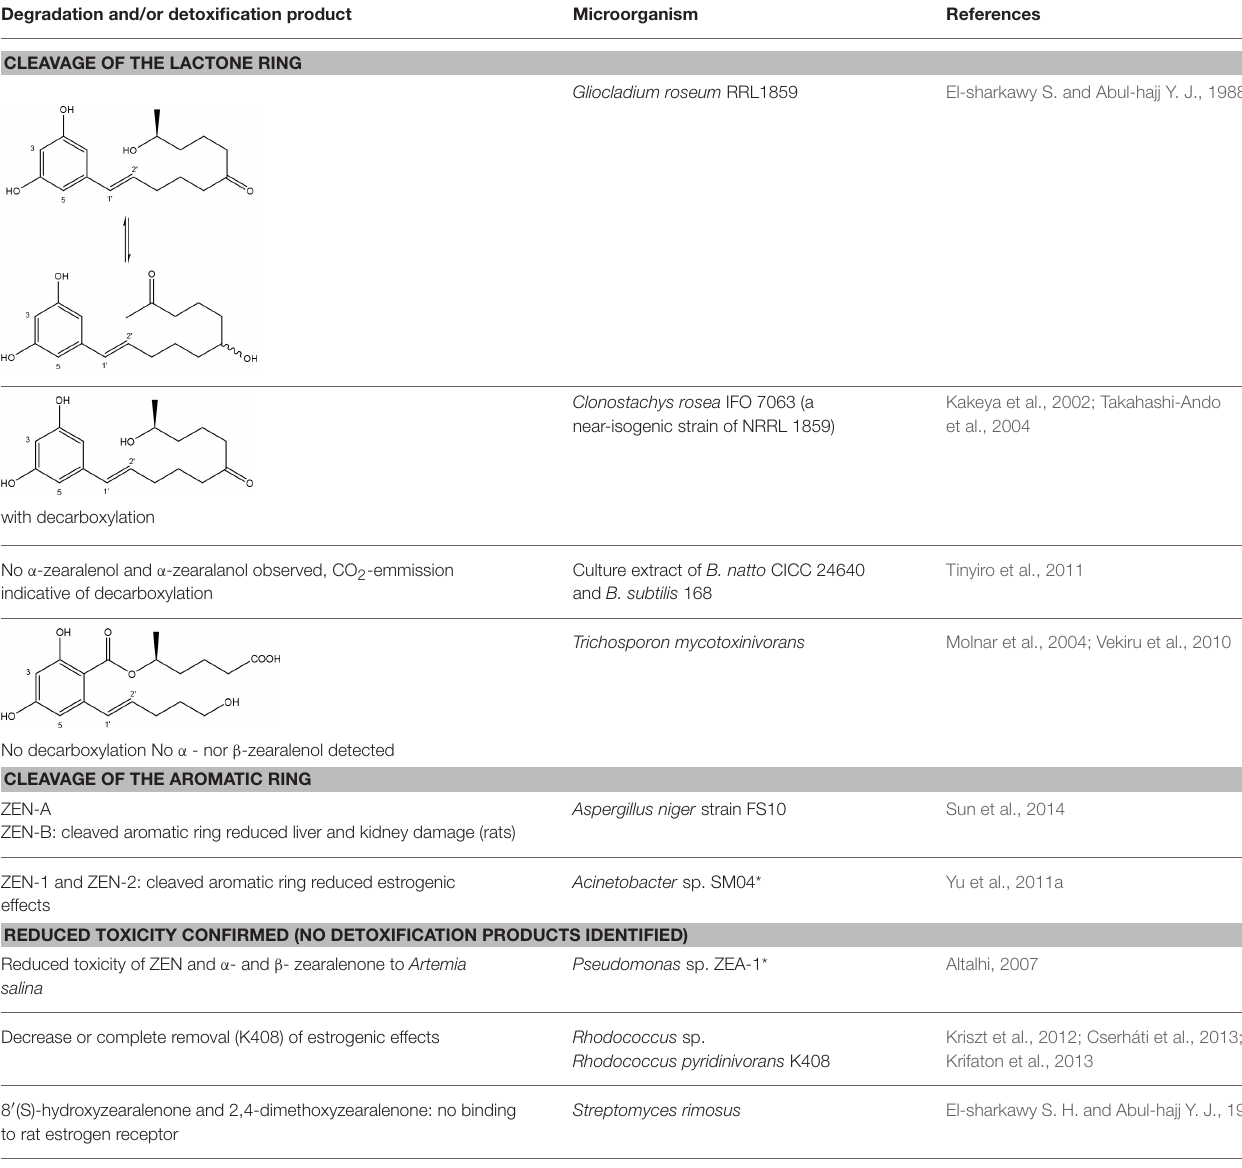
TABLE 3 | Degradation and/or detoxification products of